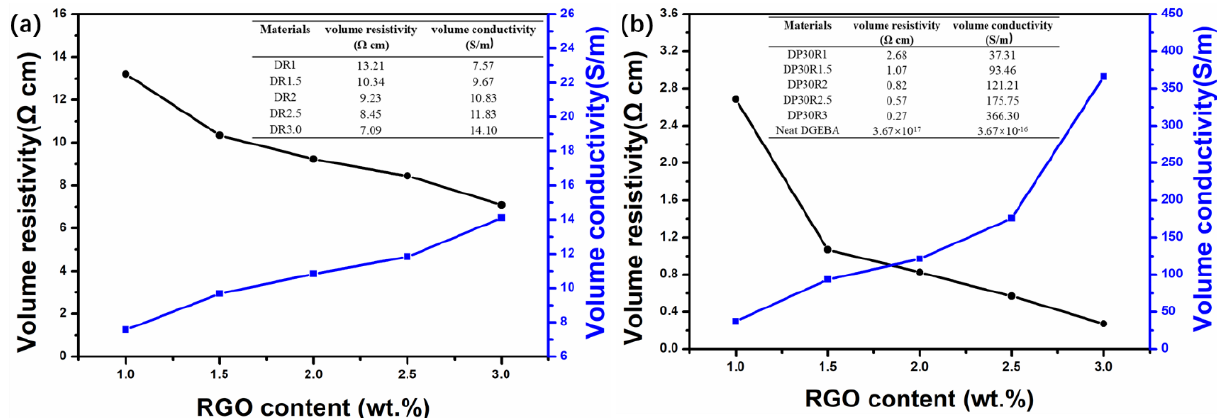
Figure 6. The volume resistivity and volume conductivity of ( a ) DR n 2 and ( b ) DP30R n 2 nanocompo- sites with varying RGO content.